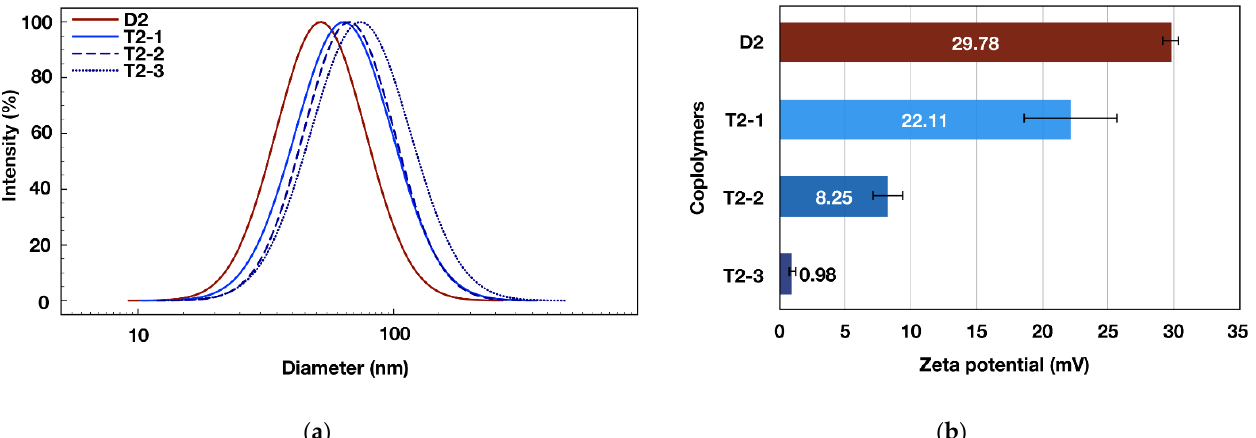
Figure 4. Micelles’ size distributions ( a ), and zeta potentials ( b ) obtained from dynamic light scat- tering analysis of aqueous dispersions (1 mg mL − 1 ) of the diblock copolymer precursor D2 (d = 52 nm, PdI: 0.180, ζ = 29.78 mV) and the corresponding amphiphilic triblock copolymers: T2-1(d = 65 nm, PdI: 0.198, ζ = 22.11 mV), T2-2 (d = 67 nm, PdI: 0.193, ζ = 8.25 mV), T2-3 (d = 72 nm, PdI: 0.200, ζ = 0.98 mV).